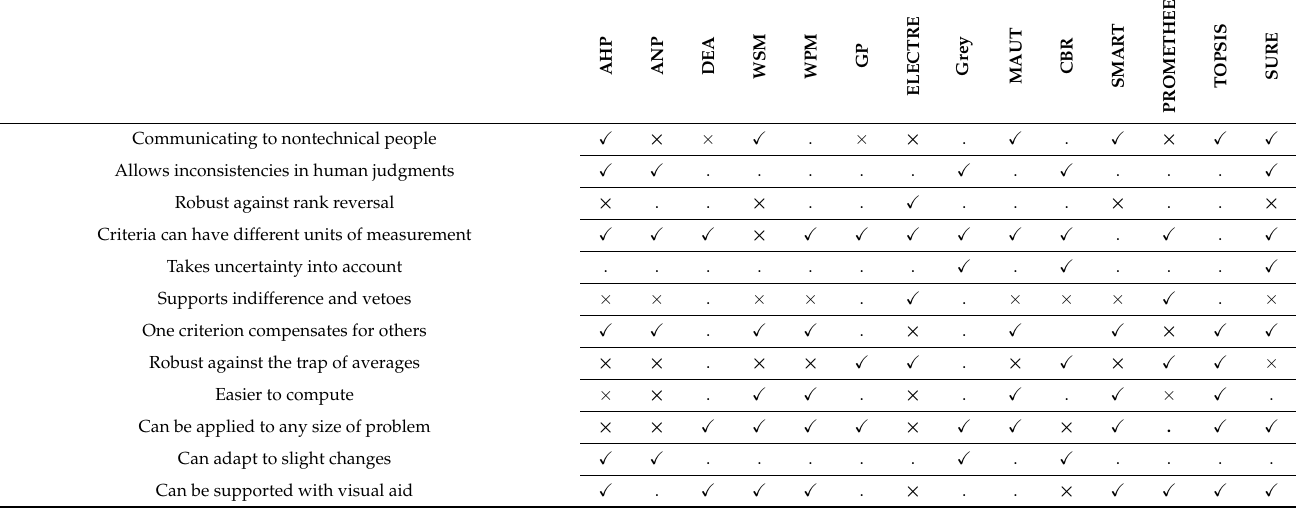
Table 13. Pros and cons of using different MCDA techniques in managing water-related